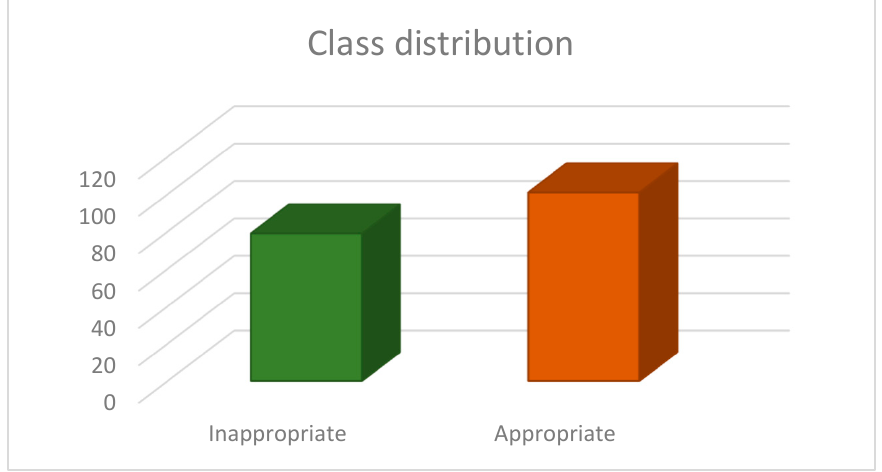
Figure 5. Distribution of ‘inappropriate’ and ‘appropriate’ classes in the Model C dataset. Table 5. Results of the Random Forest method on the Model C dataset.